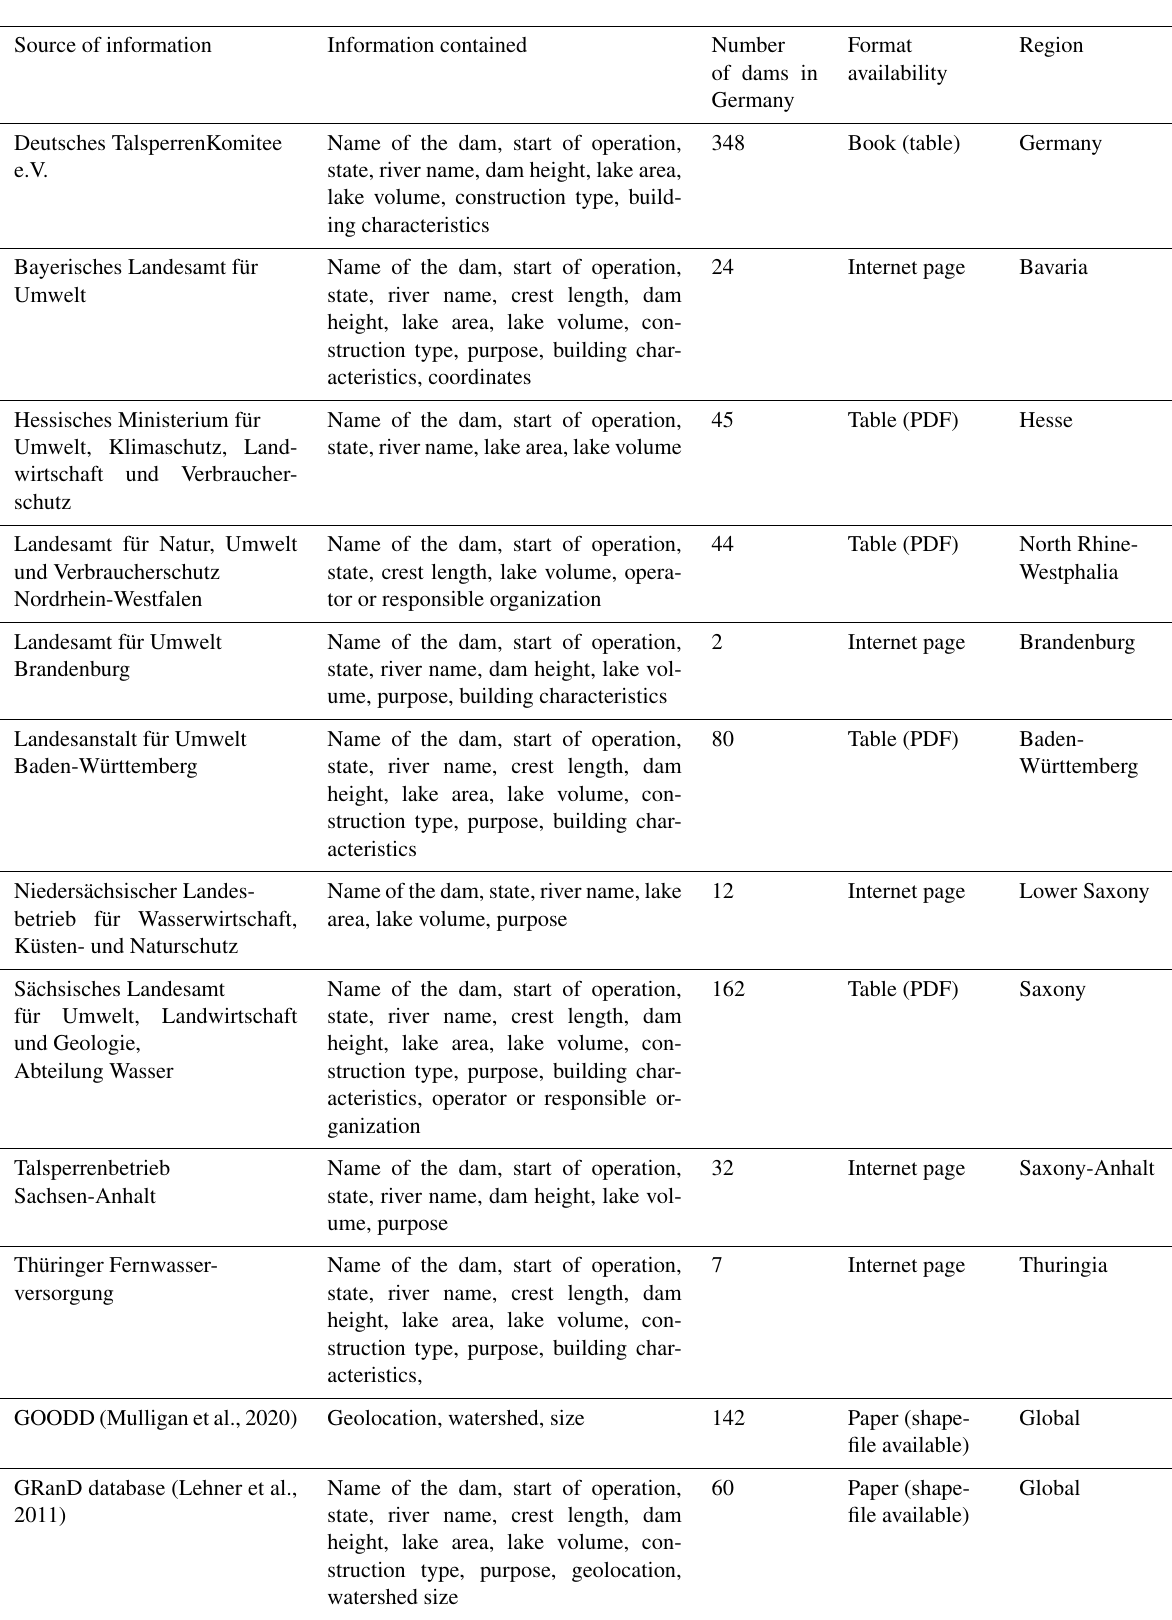
Table 1. The most relevant sources of information used to compile the DIG. Source of information Information